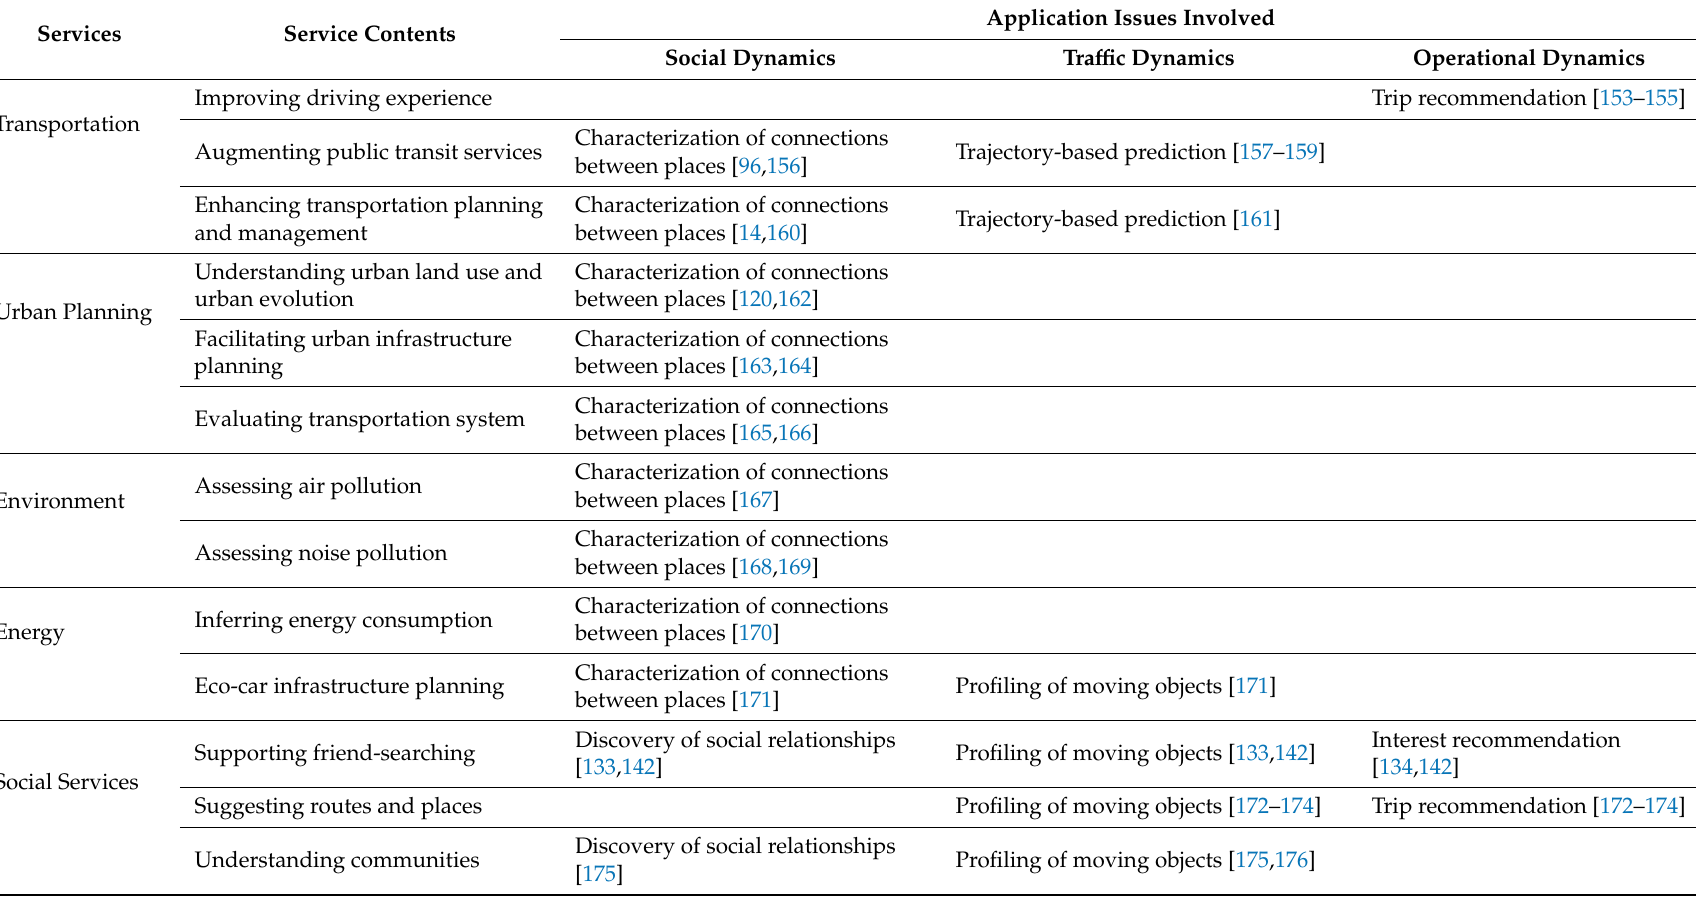
Table 3. Relationships between trajectory data-based services and application